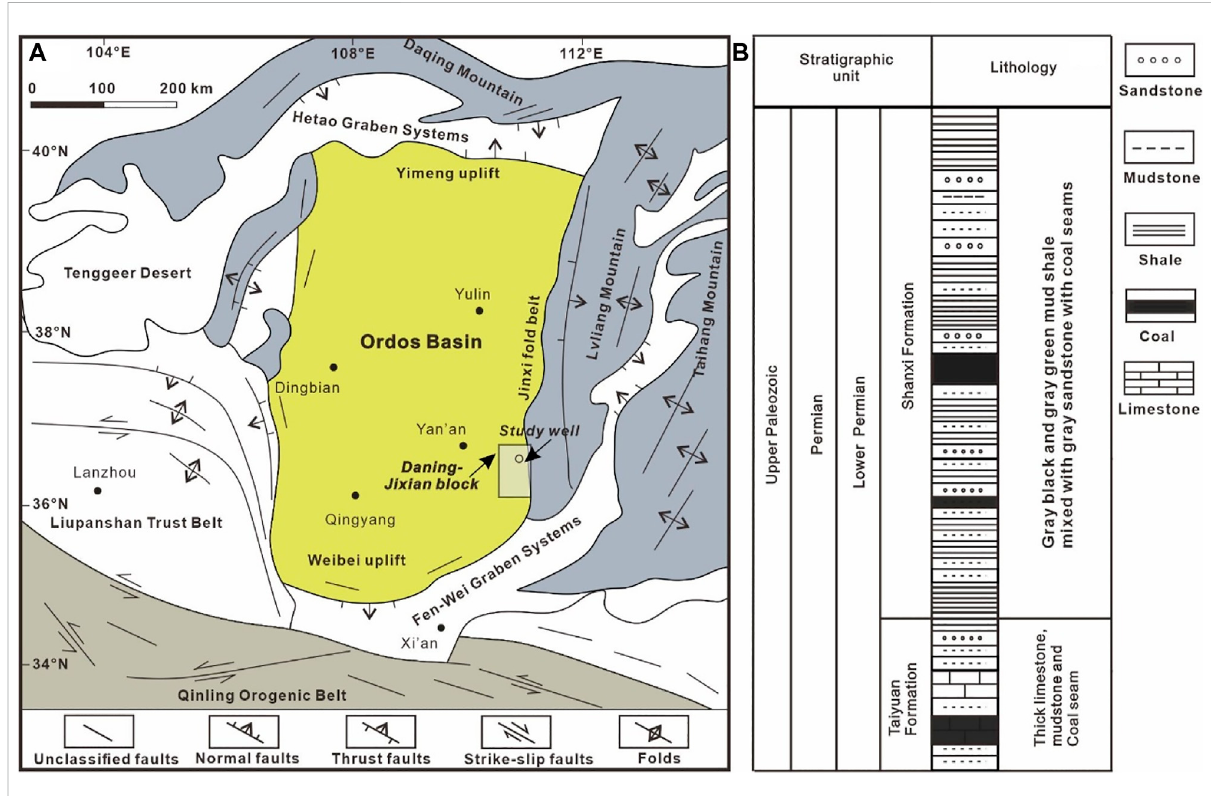
FIGURE 1 Geological map (A) , after Ju et al. (2021) and stratigraphic information (B) of the southeast Ordos Basin.